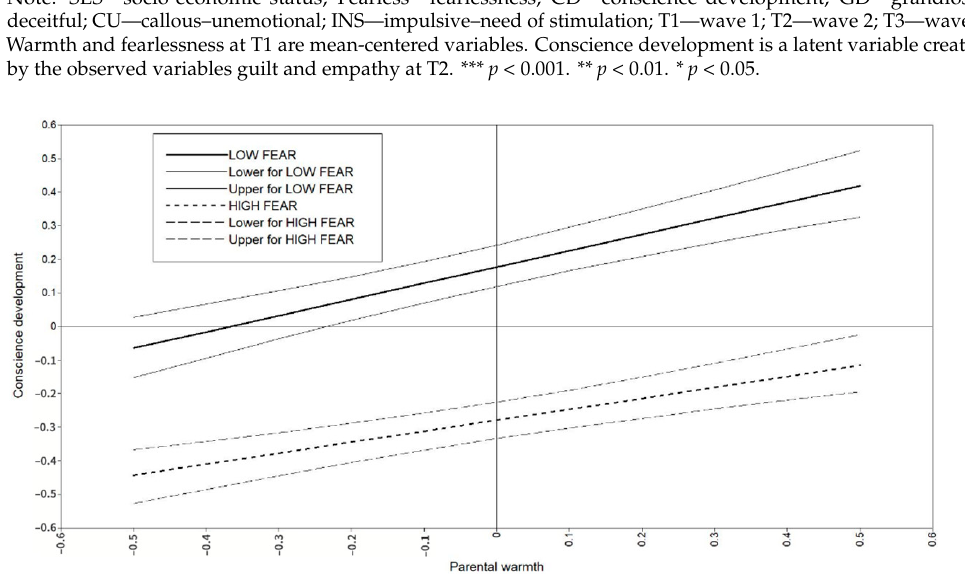
Table 2. Standardized direct effects from the SEM testing the conceptual model of conditional indirect effects.